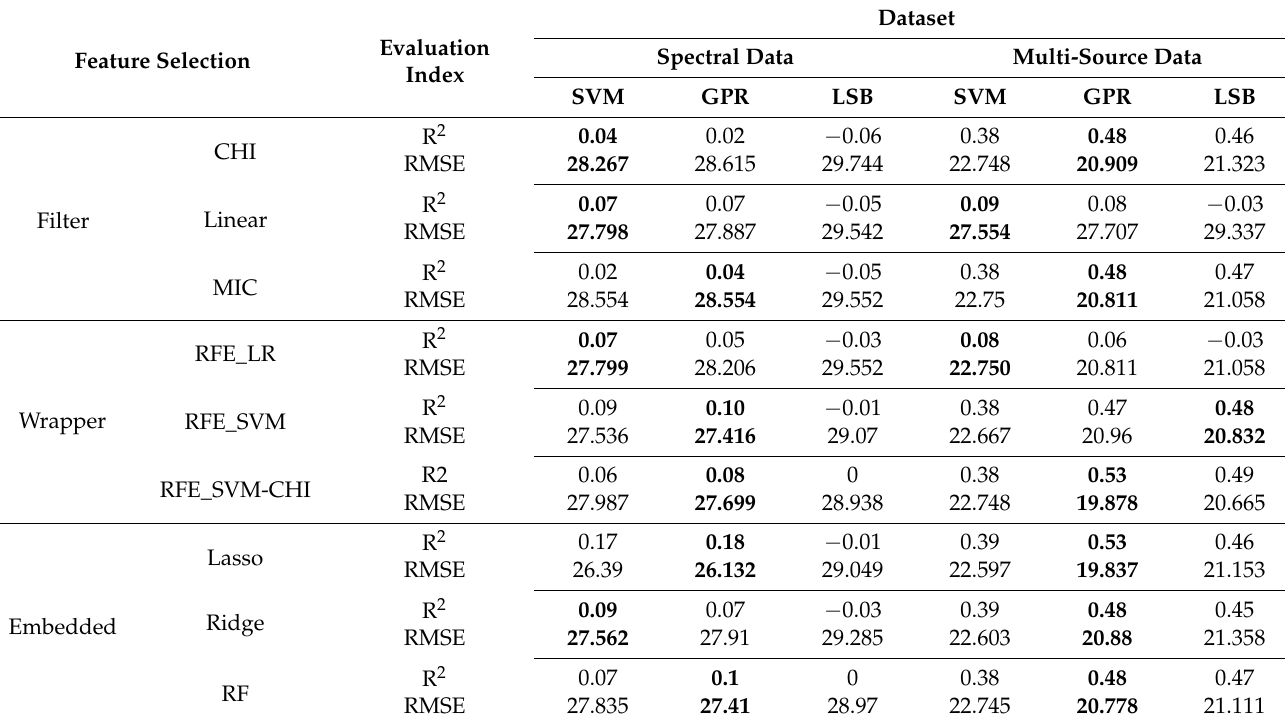
Table 3. Regression results based on different feature selection